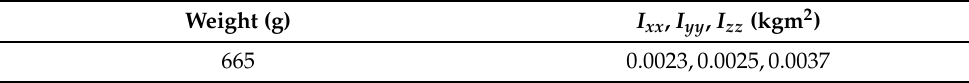
Table 1. Physical parameters of the